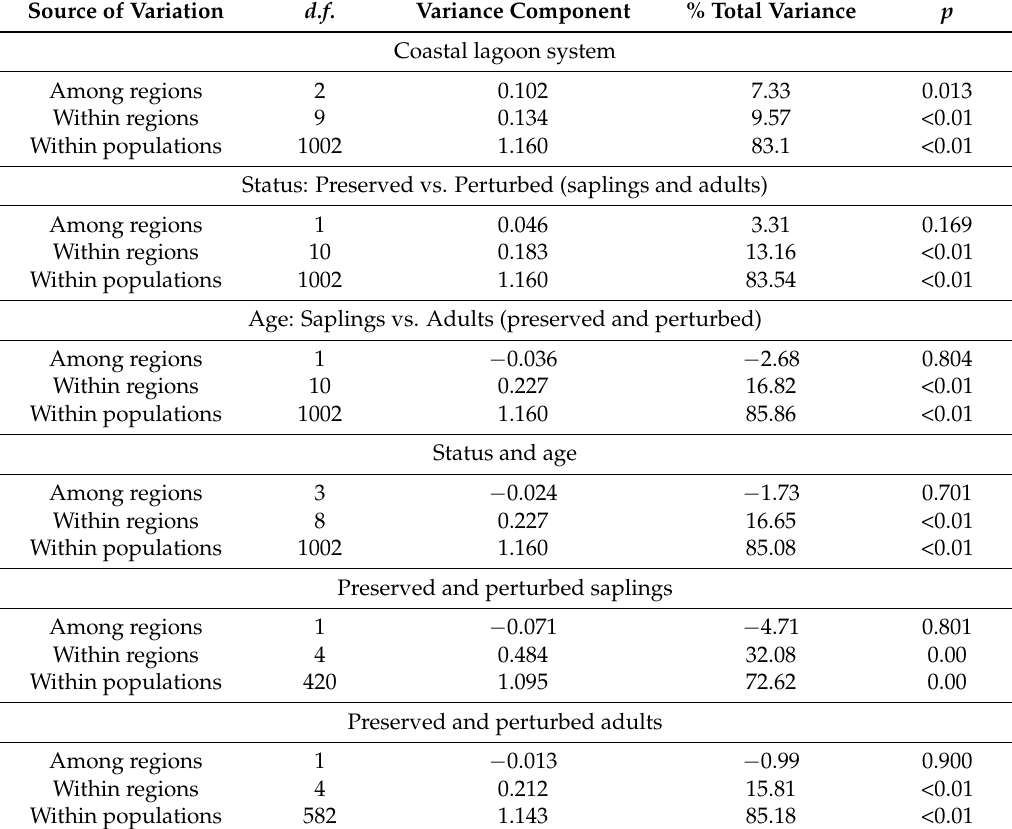
Figure 3. Results derived from STRUCTURE analysis of the three lagoon systems based on their age and status conservation (preserved and perturbed), where ( A ) is represented by two genetics groups of adults; and ( B ) assignment of three genetics groups of saplings individuals. The assignments of populations are: H (Huizache); C (Caimanero); URI per (Urias perturbed); URI pre (Urias preserved); CEU pre (Ceuta preserved); CEU per (Ceuta perturbed). Table 2. Results of hierarchical AMOVA of Avicennia germinans populations based on five level analyses. Source of